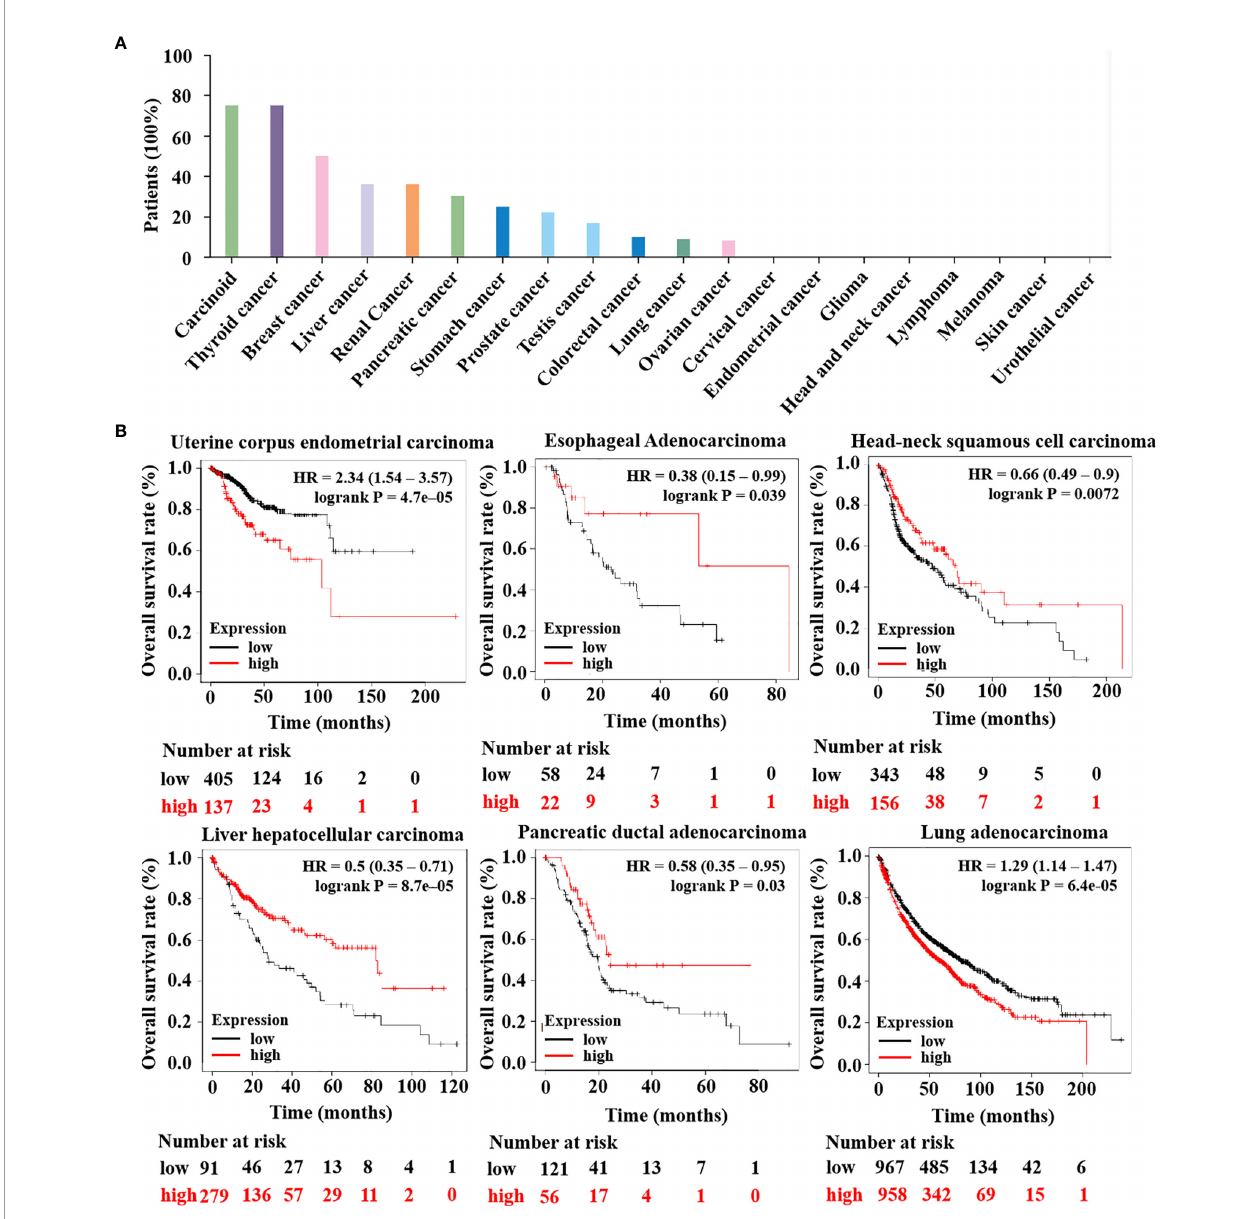
FIGURE 2 | The expression of HTR6 was associated with the OS of a variety of tumors. (A) HTR6 protein was expressed in many tumors, including breast cancer. (B) The expression of HTR6 was associated with the OS of multiple